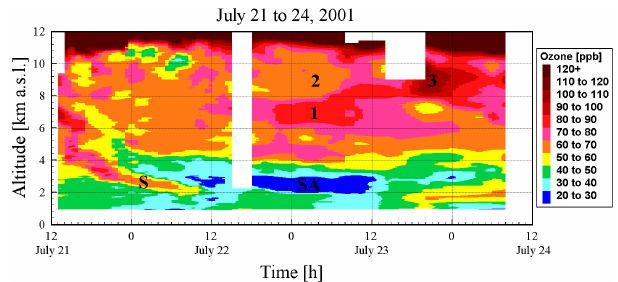
Fig. 11. Retroplume time-height sections from the twenty-day simulation for three selected altitude ranges above Garmisch- Partenkirchen initiated at the time of the lidar measurement in Fig. 8c; for details see Fig. 5 and Sect. 2.2. The simulations for Fig. 8b look similar.